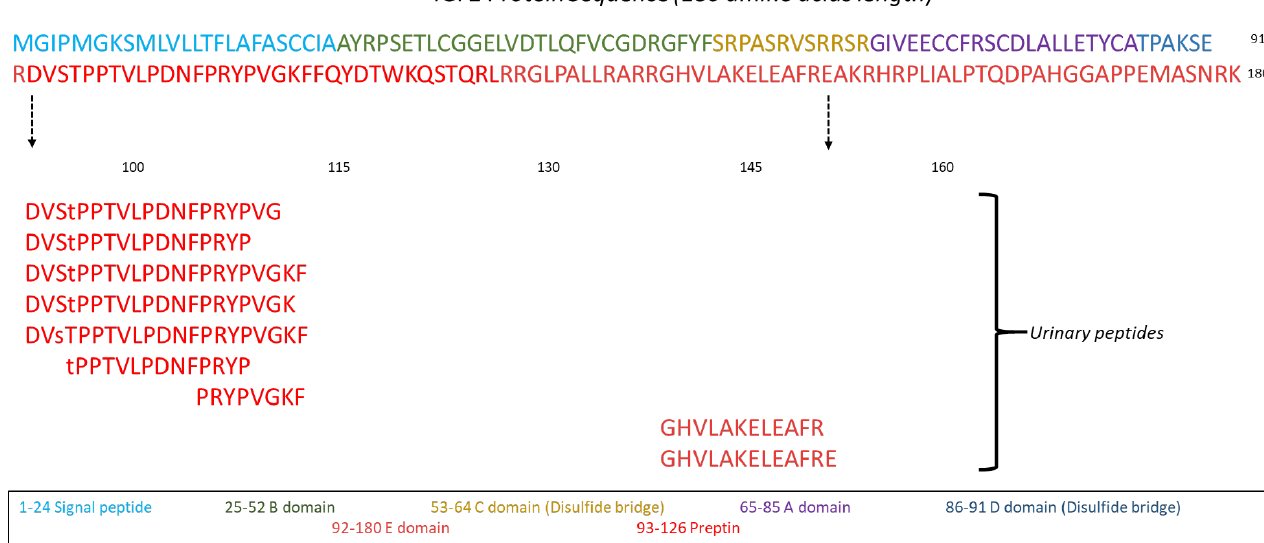
Figure 3. Identified naturally occurring IGF2 urinary peptides and their position in the IGF2 protein sequence. Lowercase “s” or “t” represent the presence of an O -linked glycan moiety.